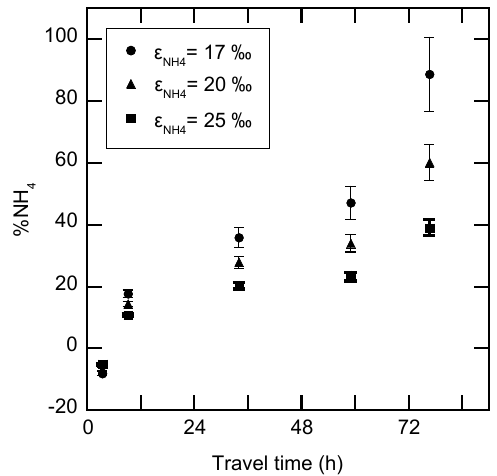
Figure 6. Modeled percentage of phytoplankton N sourced form NH + (%NH 4 ) versus travel time past the wastewater treatment 4 plant in the October parcel that received effluent ( + EFF). Calcu- lations were made using an enrichment factor for NO − three different enrichment factors for NH + ror bars indicate propagated error from the ± 0.8‰ uncertainty in δ 15 N-PHY values. See text for